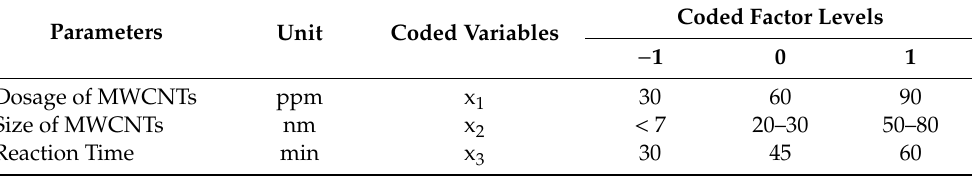
Table 1. Box–Behnken coded and uncoded independent variables for optimization of the blending process parameters for the rice bran methyl ester (RBME) blending with multi-walled carbon nanotubes